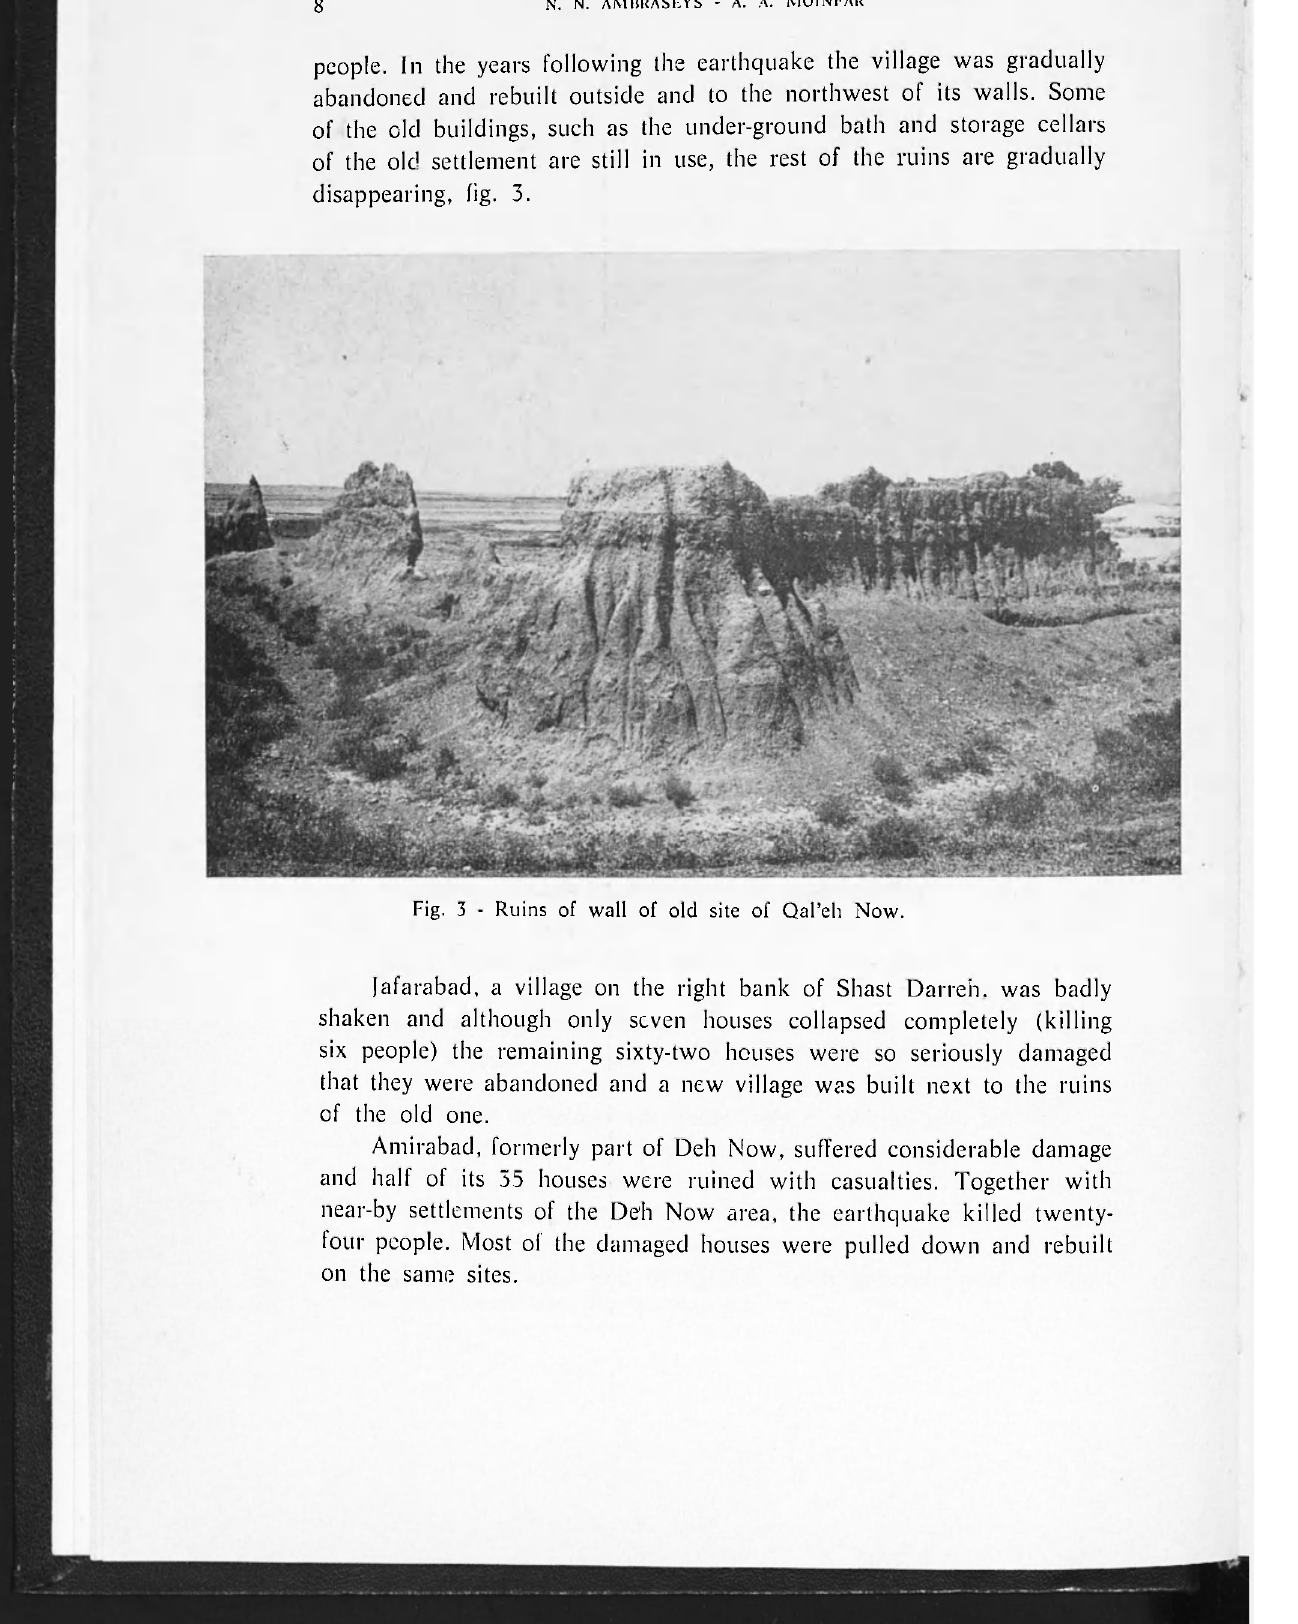
Fig. 3 - Ruins of wall of old site of Qal'eh